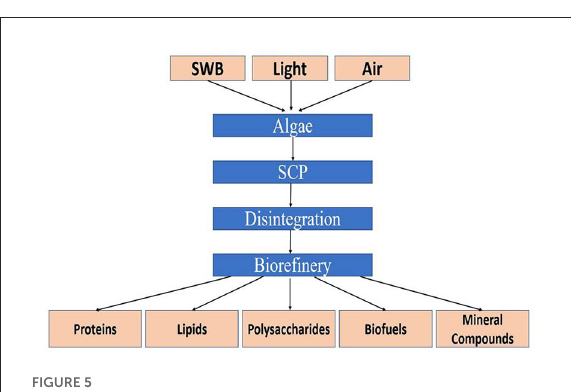
FIGURE5 Microalgae-based bioconversion of seafood nutrients into value-added protein and other products. Source: Venugopal (131), with permission from